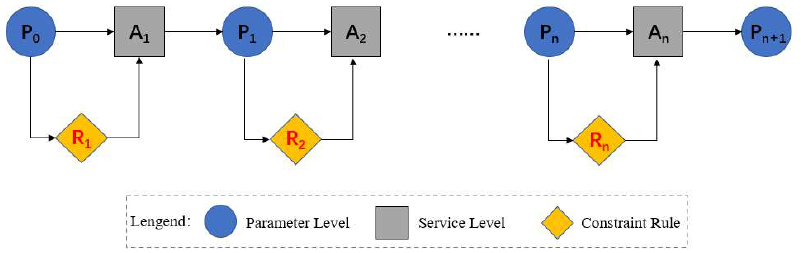
Figure 4. Illustration of the service planning graph construction method.